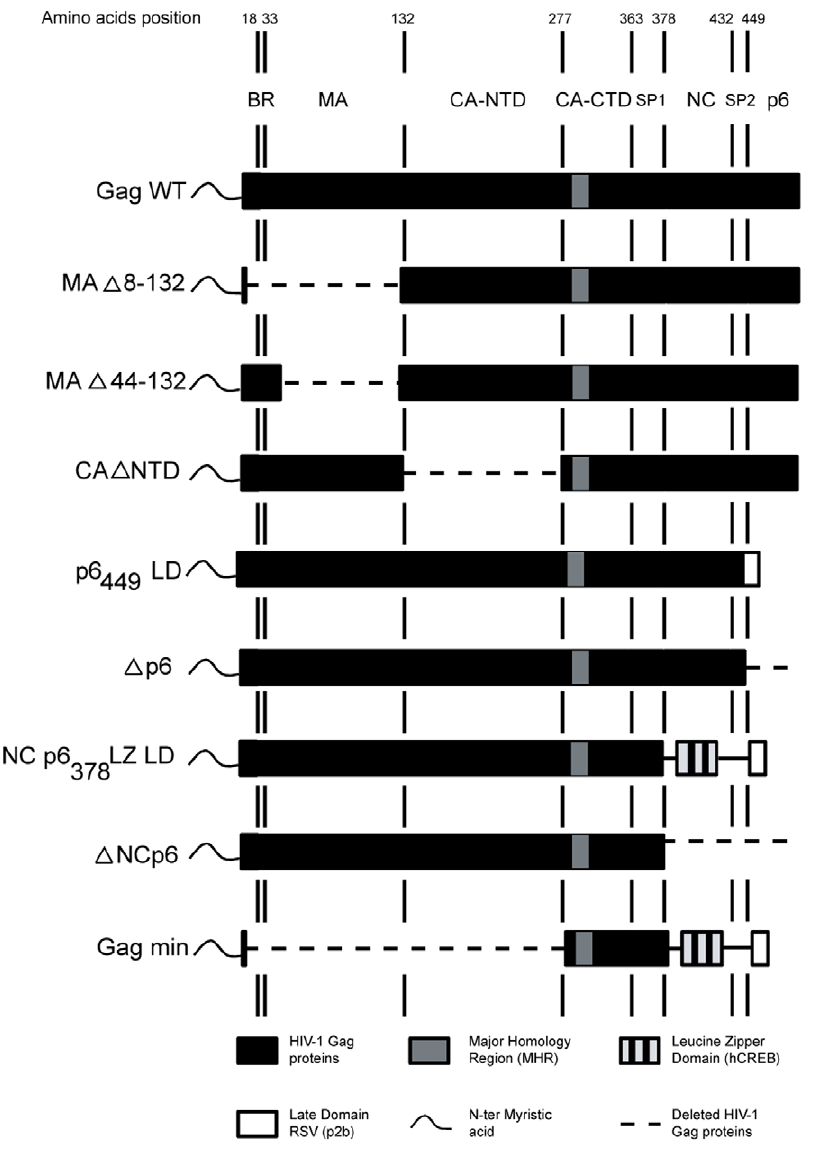
Figure 1. Schematic representation of the different HIV-1 Pr55 Gag -derived constructs used in this study. The various molecular constructs, derived from the HXB2 Pr55 Gag sequence (designated here as Gag WT), were made by PCR as described under the Materials and Methods section. All constructs contain the wild-type myristic acid post-translational sequence in the N-terminal position and all were subcloned into the pcDNA3.1 ( + ) eukaryotic expression vector. Wild-type HIV-1 sequences are denoted in black, and deleted virus sequences correspond to the dotted line. Numbers above correspond to amino acids in the wild-type sequence. BR, basic region of MA; NTD, N-terminal domain; CTD, C-terminal domain.